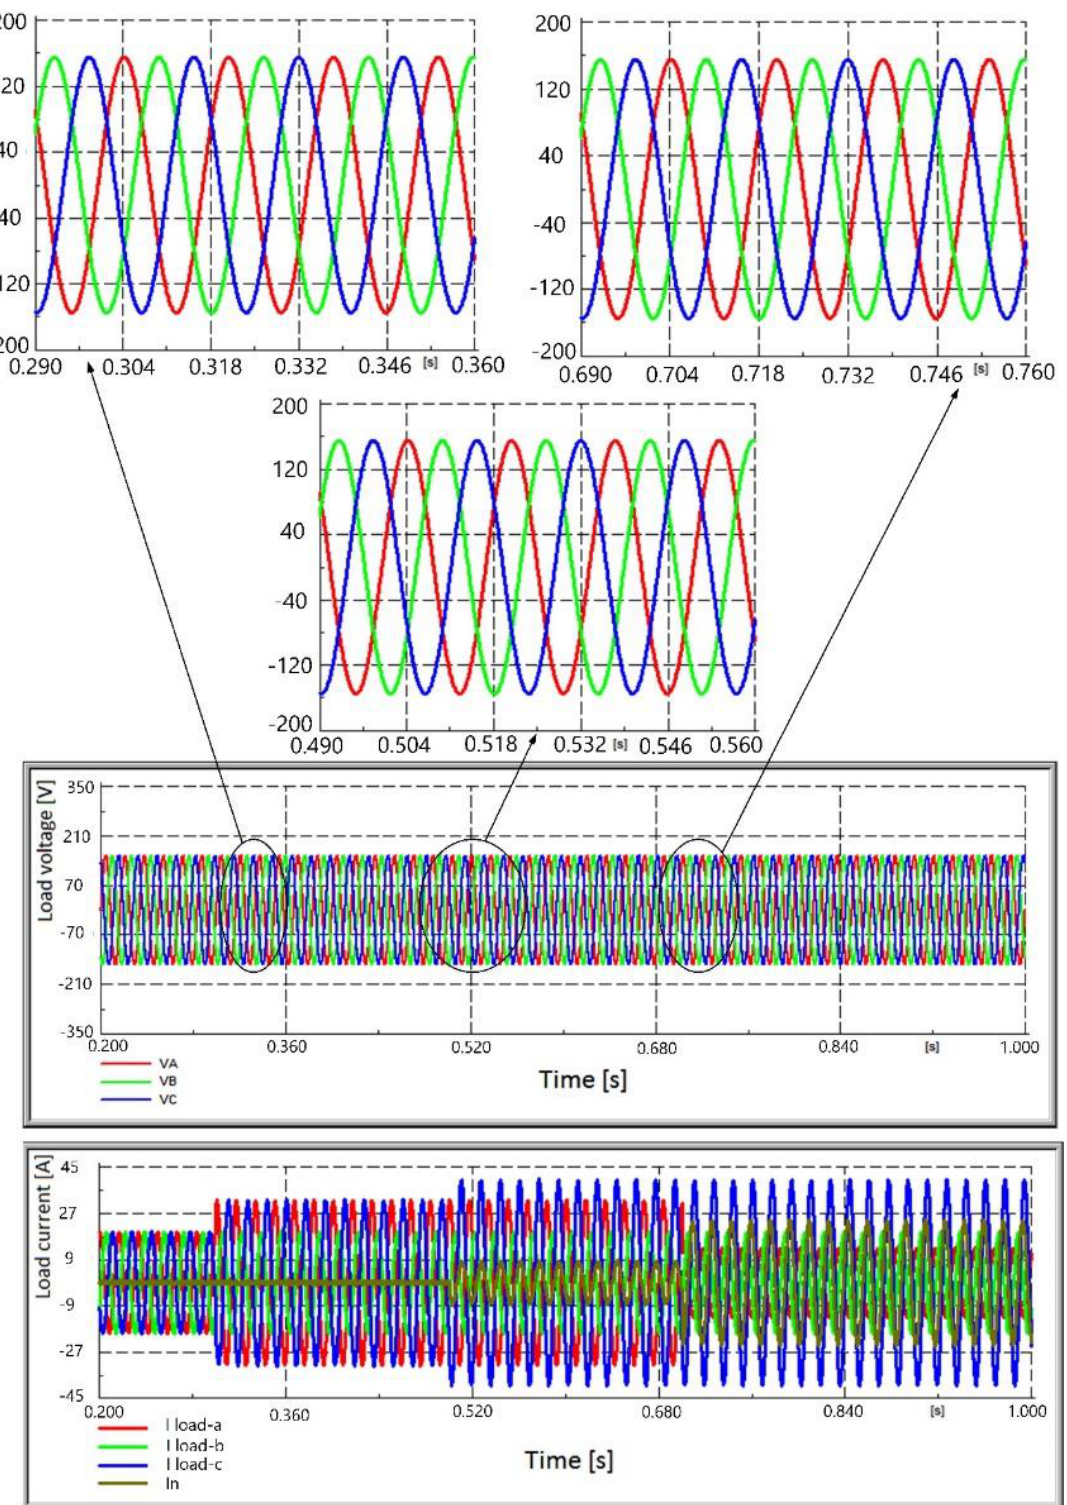
Figure 10. Output voltages and currents with the proposed control strategy under suddenly load changes.